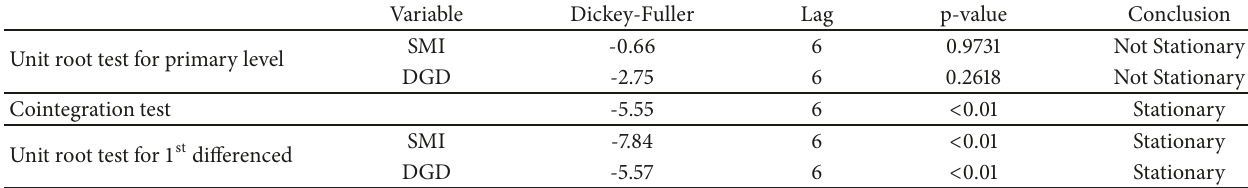
Table 4: Augmented Dickey-Fuller (ADF) Test